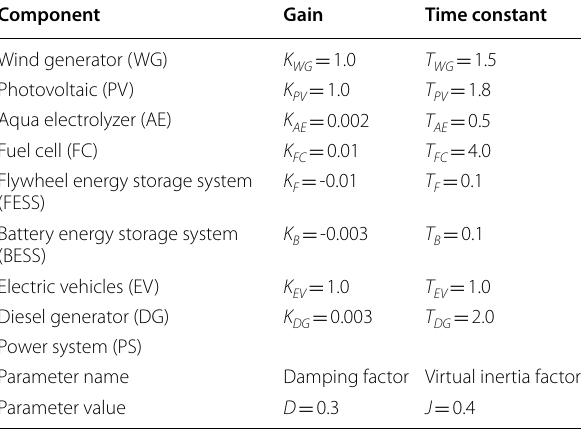
Table 3 Nominal parameters of the studied